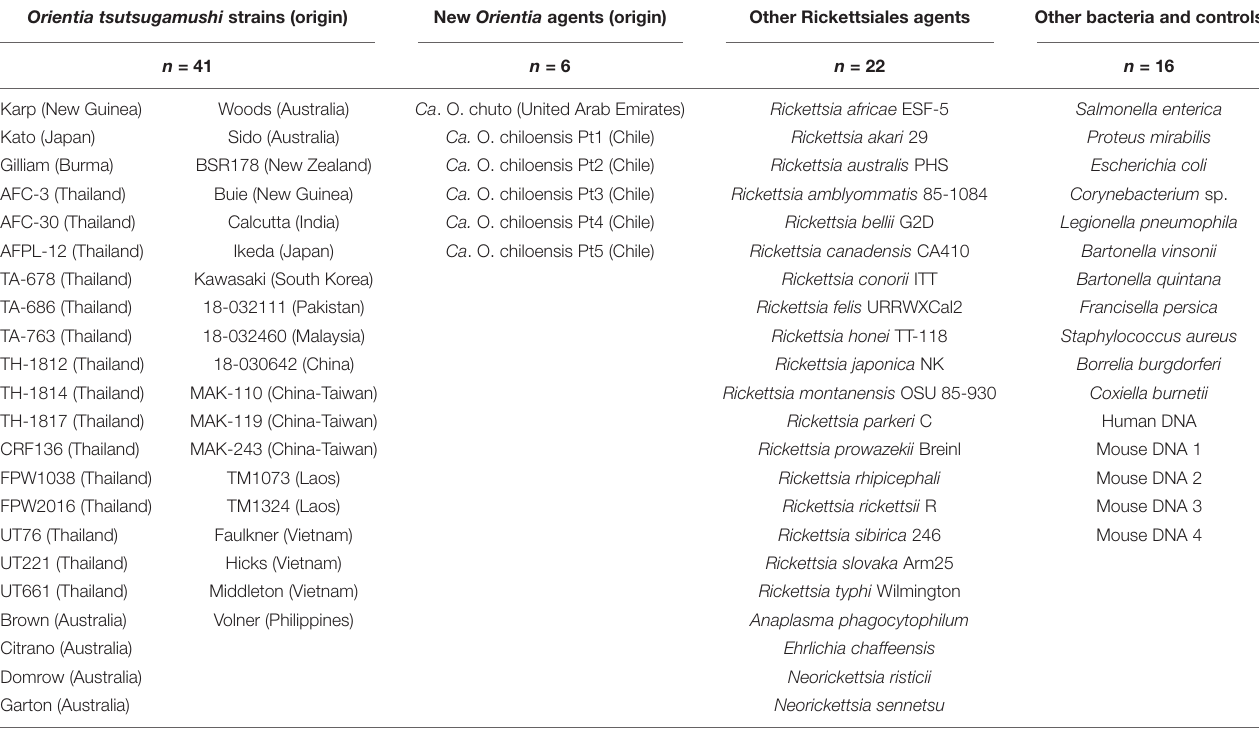
TABLE 1 | DNA preparations from bacterial strains and other sources included in the validation of the novel qPCR assay,